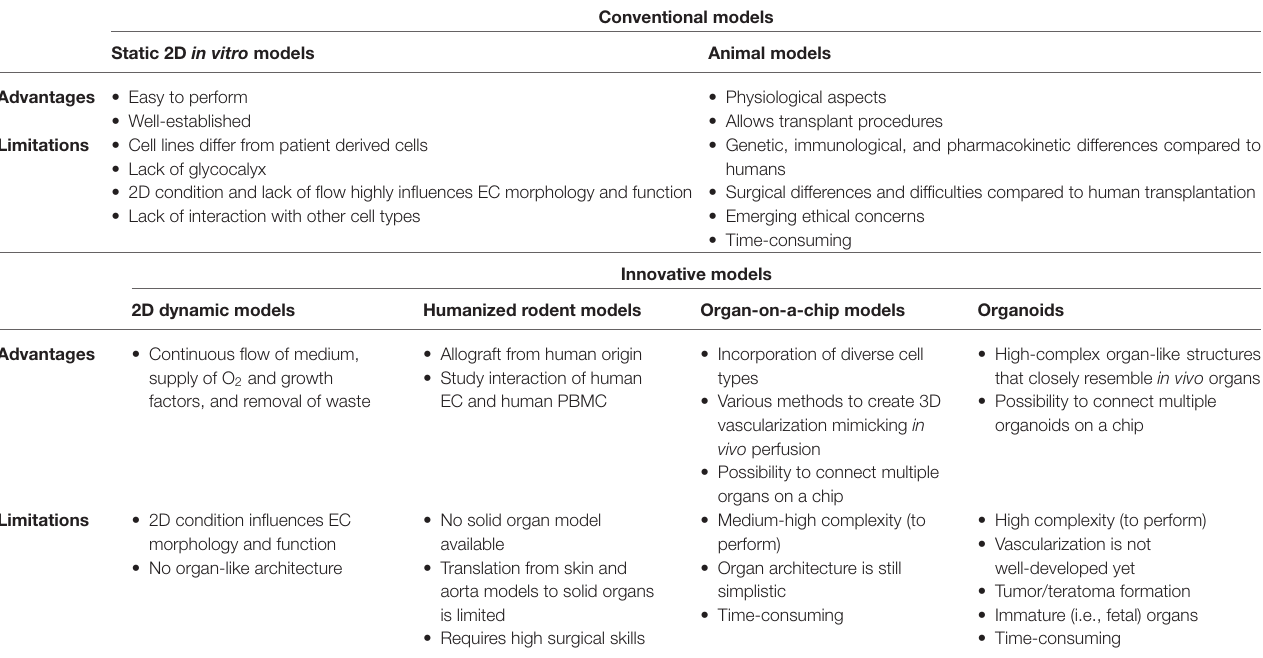
TABLE 1 | Advantages and limitations among conventional and innovative research